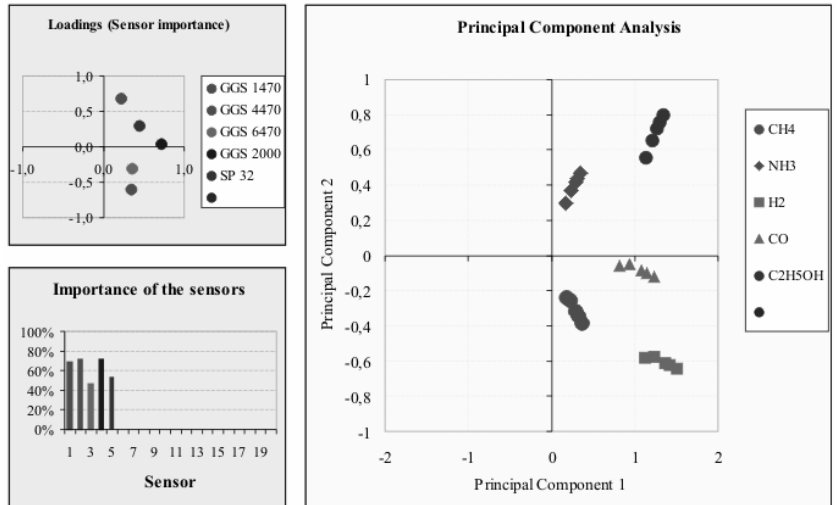
Figure 7. Results of PCA-analysis using the five semiconductor gas sensors for the qualitative classification of the gases CH